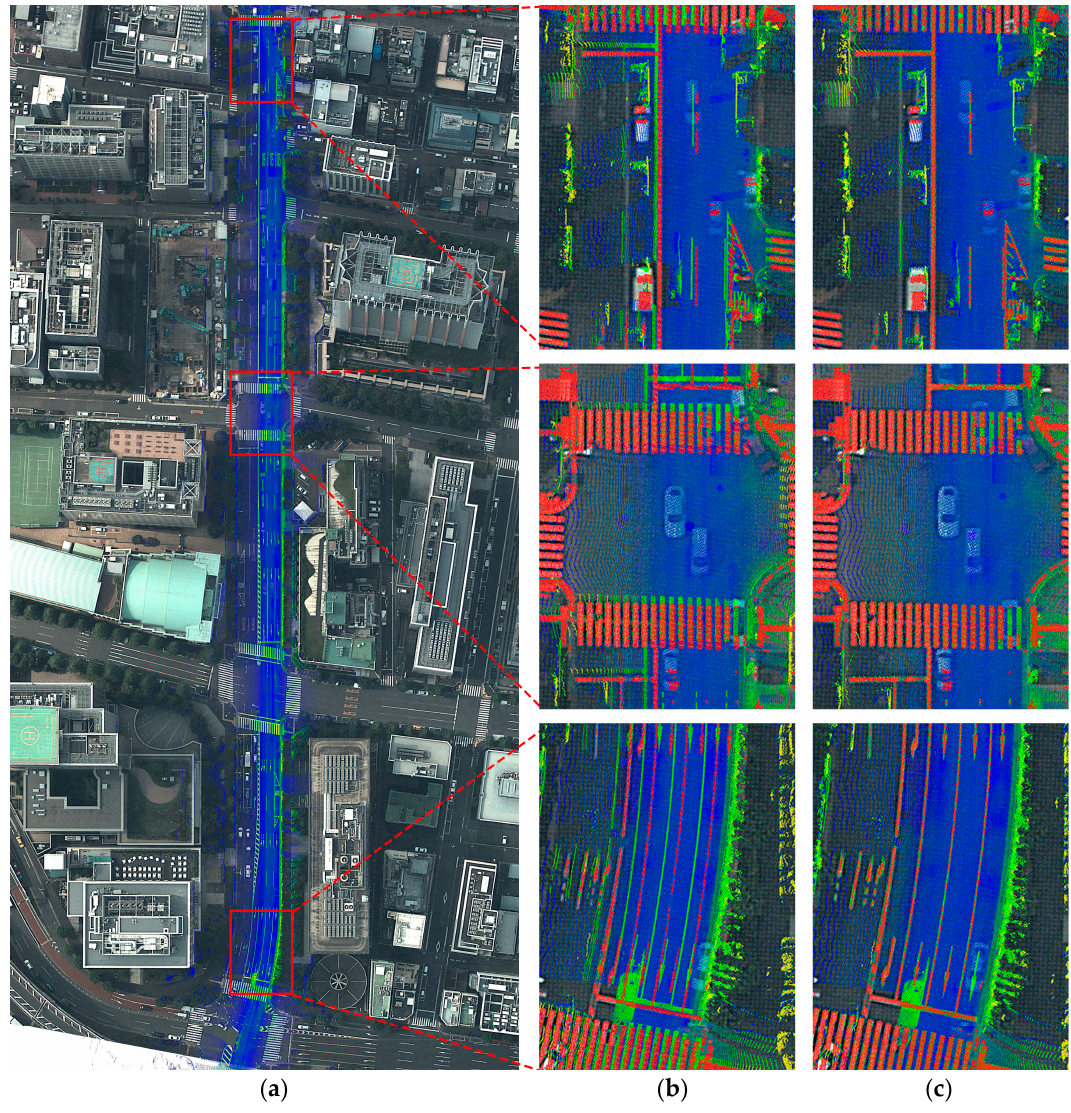
Figure 21. Visual evaluation of the proposed method for survey No. 6: ( a ) survey route of the MMS on the aerial image (after registration); ( b ) enlarged view of the original MMS point cloud before registration (the red points are aerial road markings); and ( c ) enlarged view of the MMS point cloud after applying the proposed method (the red points are aerial road markings).